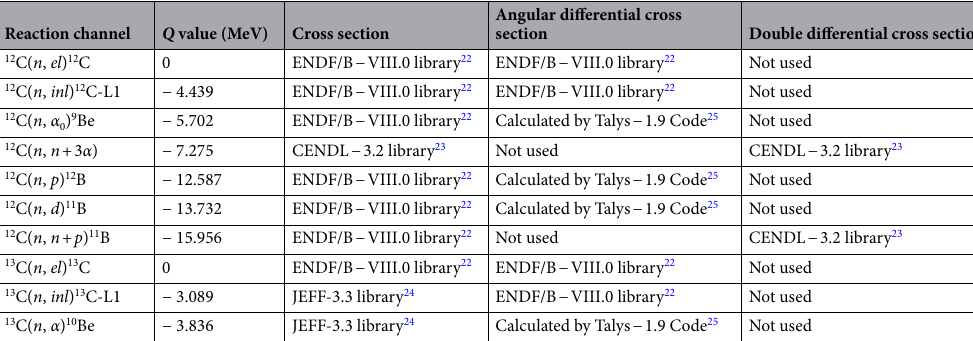
Table 1. The nuclear reaction channels, corresponding Q values and evaluated nuclear data libraries used in the simulation. el elastic scattering, inl inelastic scattering.